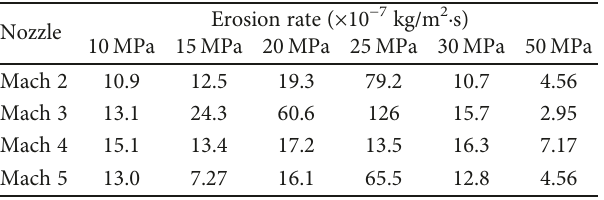
Table 1: Maximum erosion rate of di ff erent nozzles at various